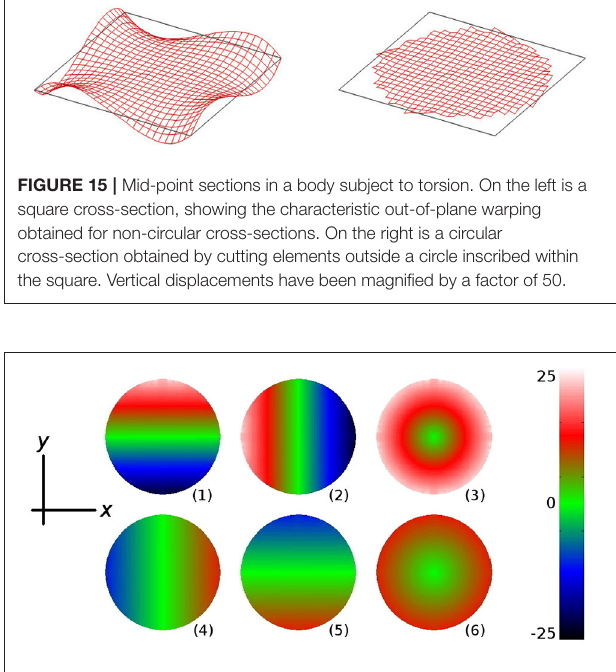
FIGURE 16 | Stresses on the central cross-section of a cylinder subjected to an external torque. Shown are stresses in discrete element “beams” which connect horizontal layers in the cylinder, i.e., “beam” 6 in Figure 1 . Shear stresses are displayed at the top and bending stresses at the bottom. See main text for more information.